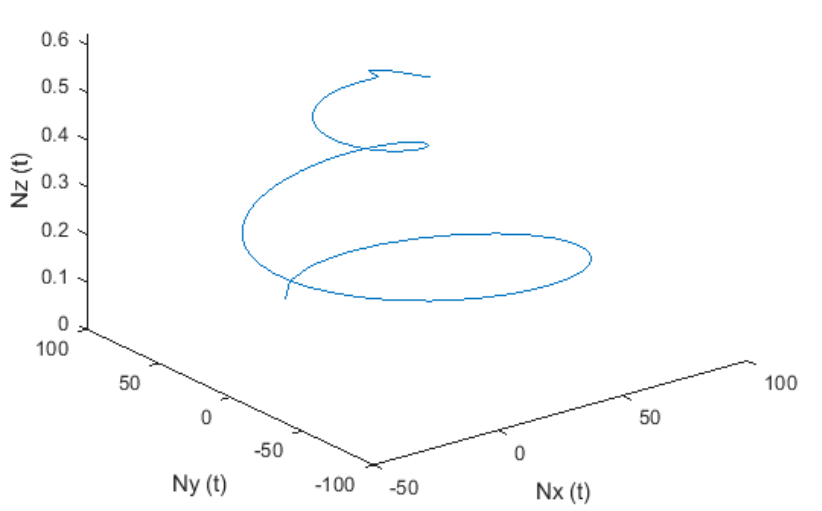
Figure 3. Numerical solutions of the Bloch equation with parameters: 𝛼 = 𝛽 = 𝛾 = 0.9 , 𝑤 (cid:2868) = 12 , 𝑇 (cid:2869) = 1 , 𝑇 (cid:2870) = 20, 𝑎 = 1, 𝑏 = 1 .